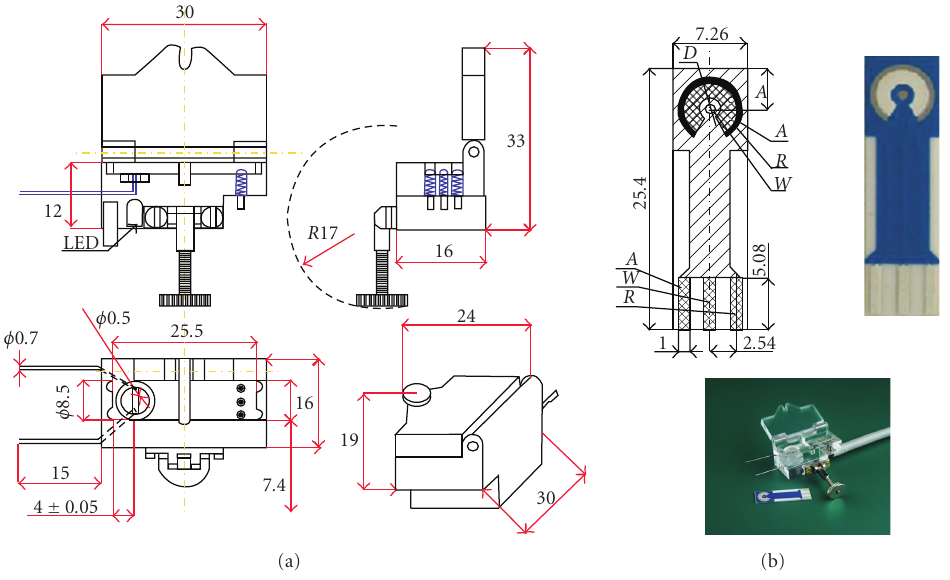
Figure 1: Flow-cell (model FC 2 ) and screen-printed electrode developed by BVT Technologies (Czech Republic). A , R , and W refer to auxiliary, reference, and working electrodes. In the present flow-cell does not exist the light emitting diode (LED) as specified in the